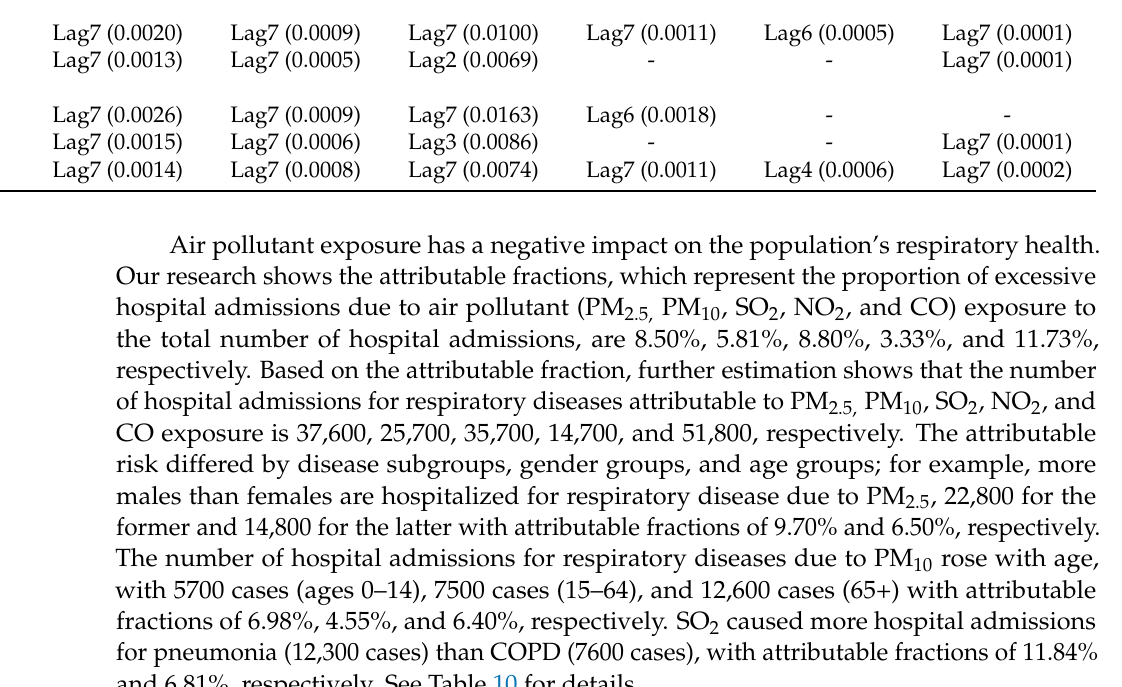
Table 9. The lag days with the greatest hysteresis effect of each air pollutant and regression coefficients ( β ). Variable Disease Subgroups